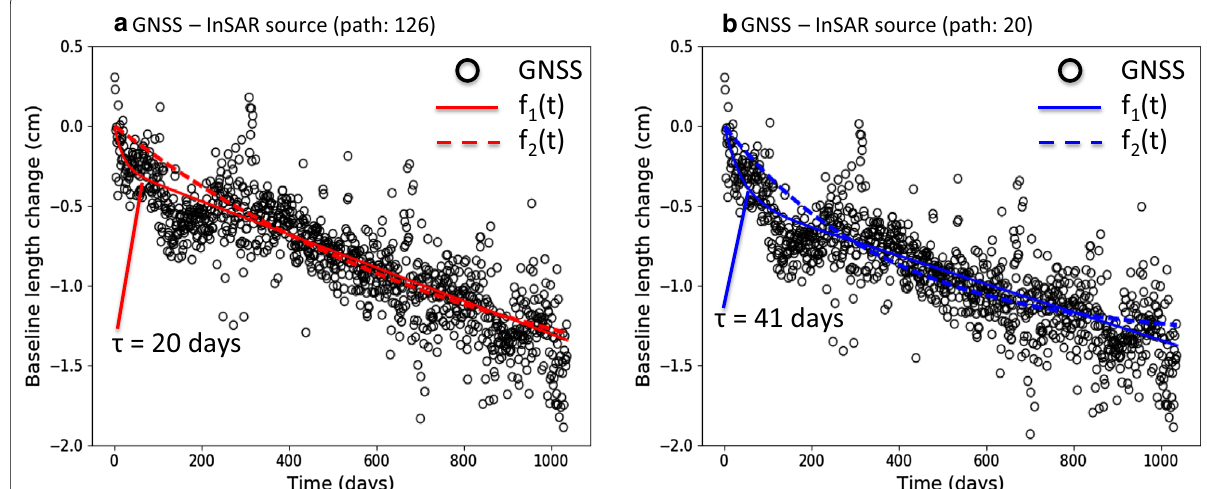
Fig. 5 Corrected time series of the GNSS baseline length change and their best-fit curves. Solid and dashed lines show best-fit curves when using f 1 ( t ) and f 2 ( t ), respectively. τ indicates the relaxation time of the decay curves with a smaller value of AIC